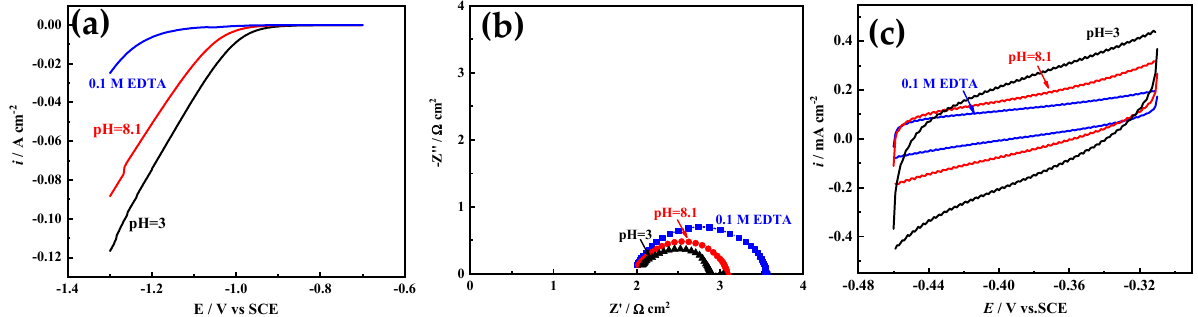
Figure 10. ( a ) The polarization curves at 10 mV s − 1 and ( b ) the Nyquist plots at 250 mV overpotential of Ni films electrodeposited in different solutions in 1 M NaOH for HER. ( c ) The cyclic voltammetry curves of Ni films with a potential range from − 0.31 to − 0.46 V at 10 mV s − 1 in 1 M NaOH.